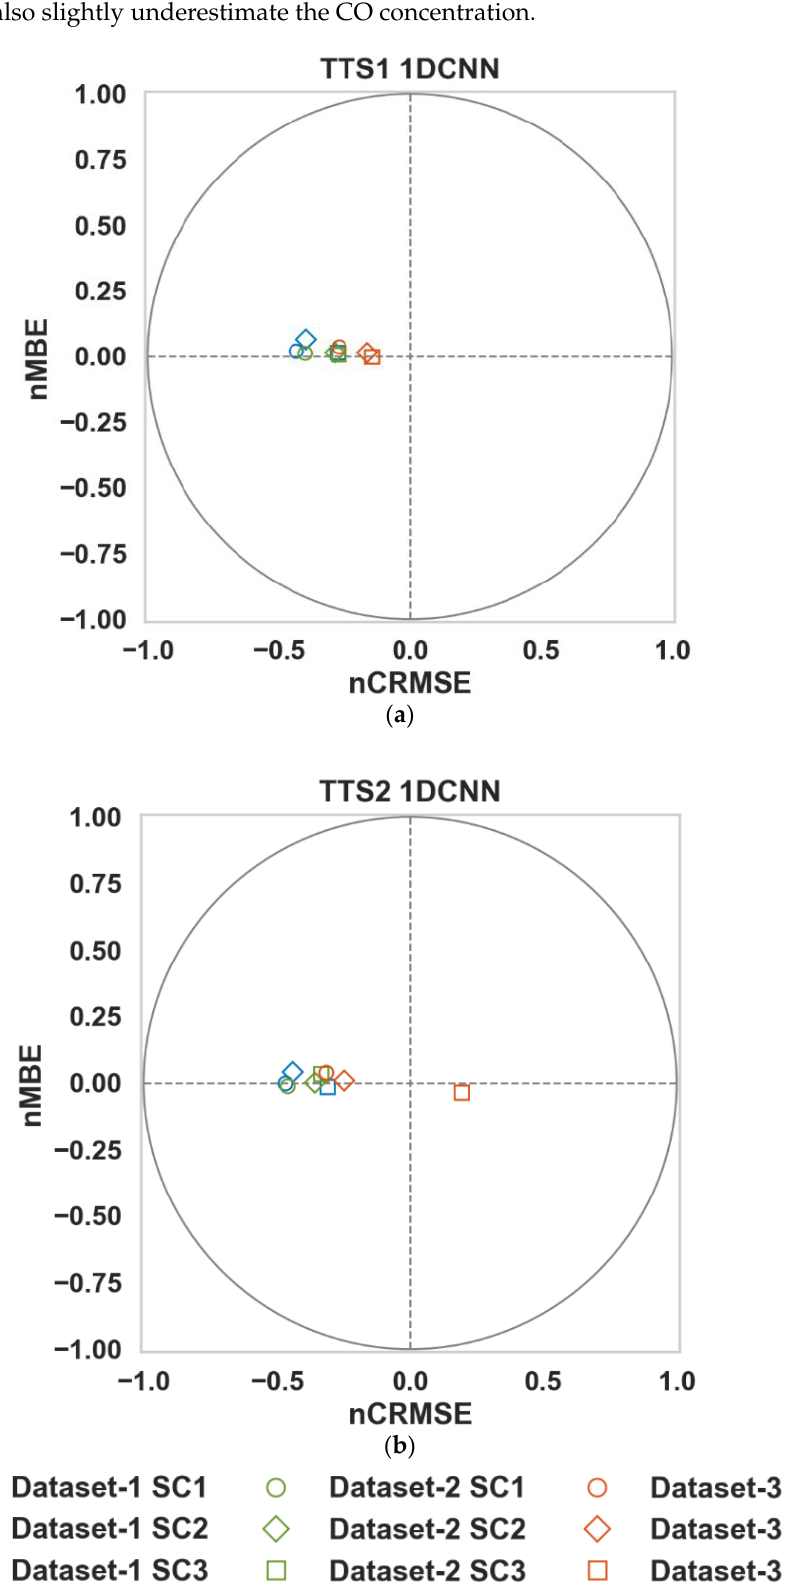
Figure 6. Target diagrams of 1DCNN for Datasets ( a ) TTS1 (90/10) and ( b ) TTS2 (20/80).